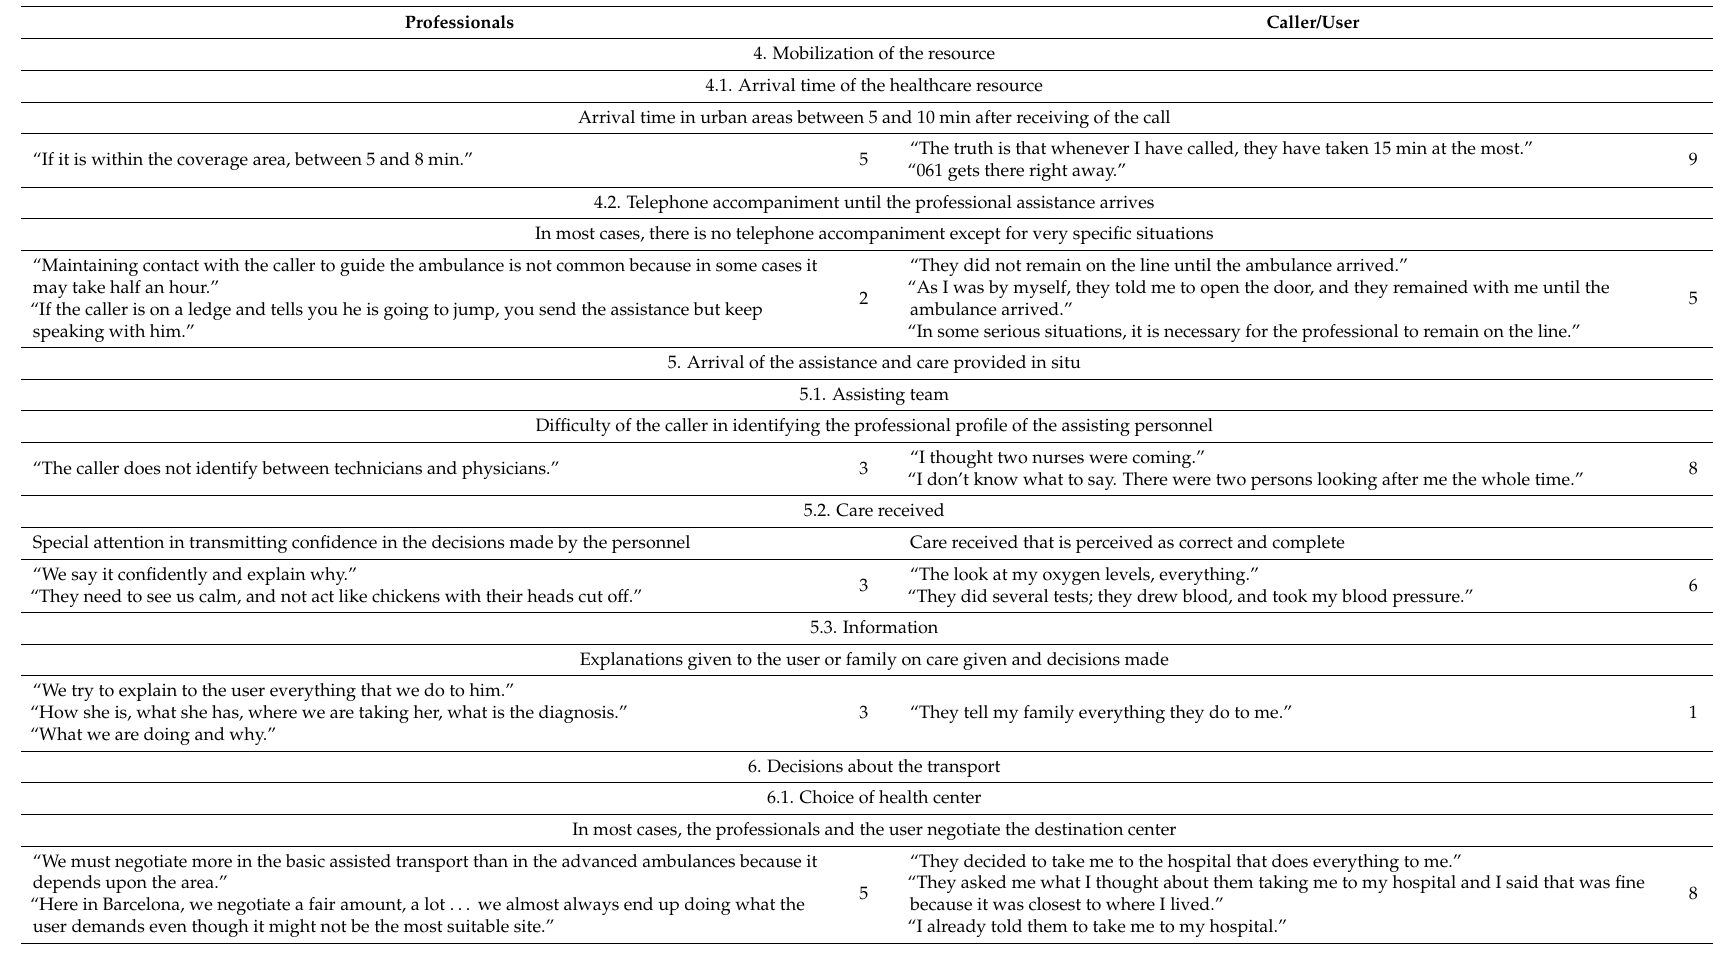
Table 4. Subprocess 3: Urgent Healthcare